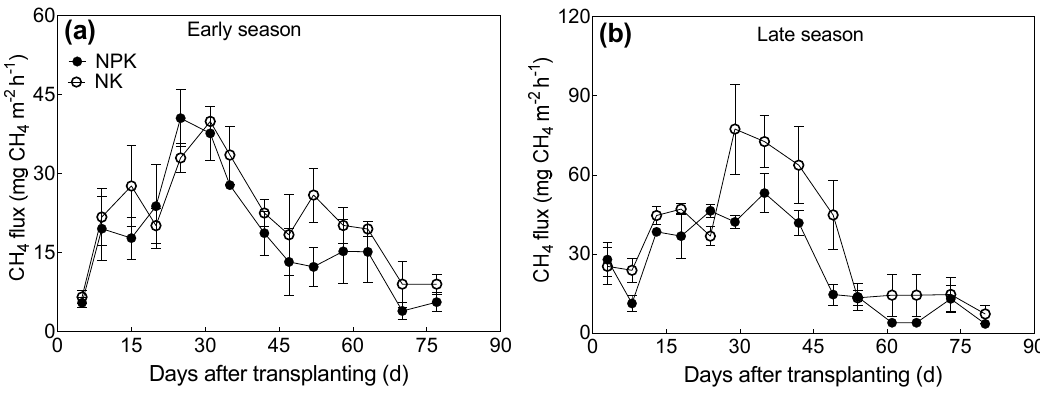
Figure 2. CH 4 fluxes from paddy fields under different long-term P addition treatments during early ( a ) and late ( b ) rice seasons. NPK: long-term N, P, and K fertilizers application; NK: long-term N and K fertilizers application. Error bars represent S.E. ( n = 3).